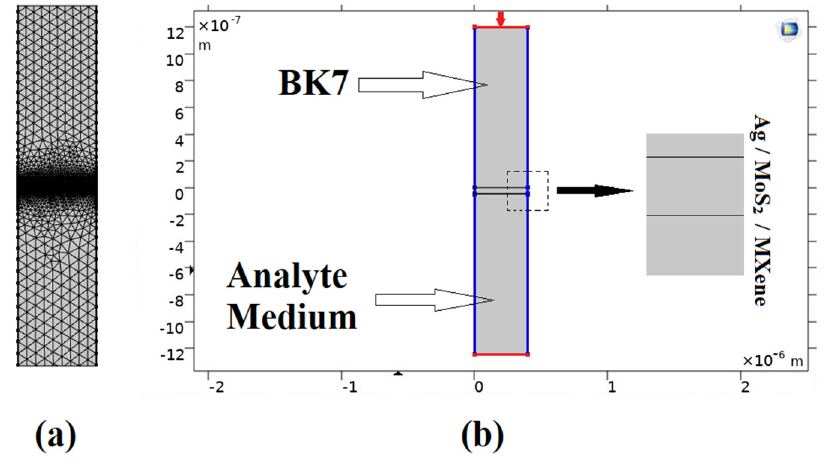
Figure 2. COMSOL Multiphysics design layout for the proposed (BK7/ Ag/ MoS 2 / MXene) SPR bi- osensor: ( a ) The field of computational meshing; ( b ) A simulation-based model for the proposed structure.